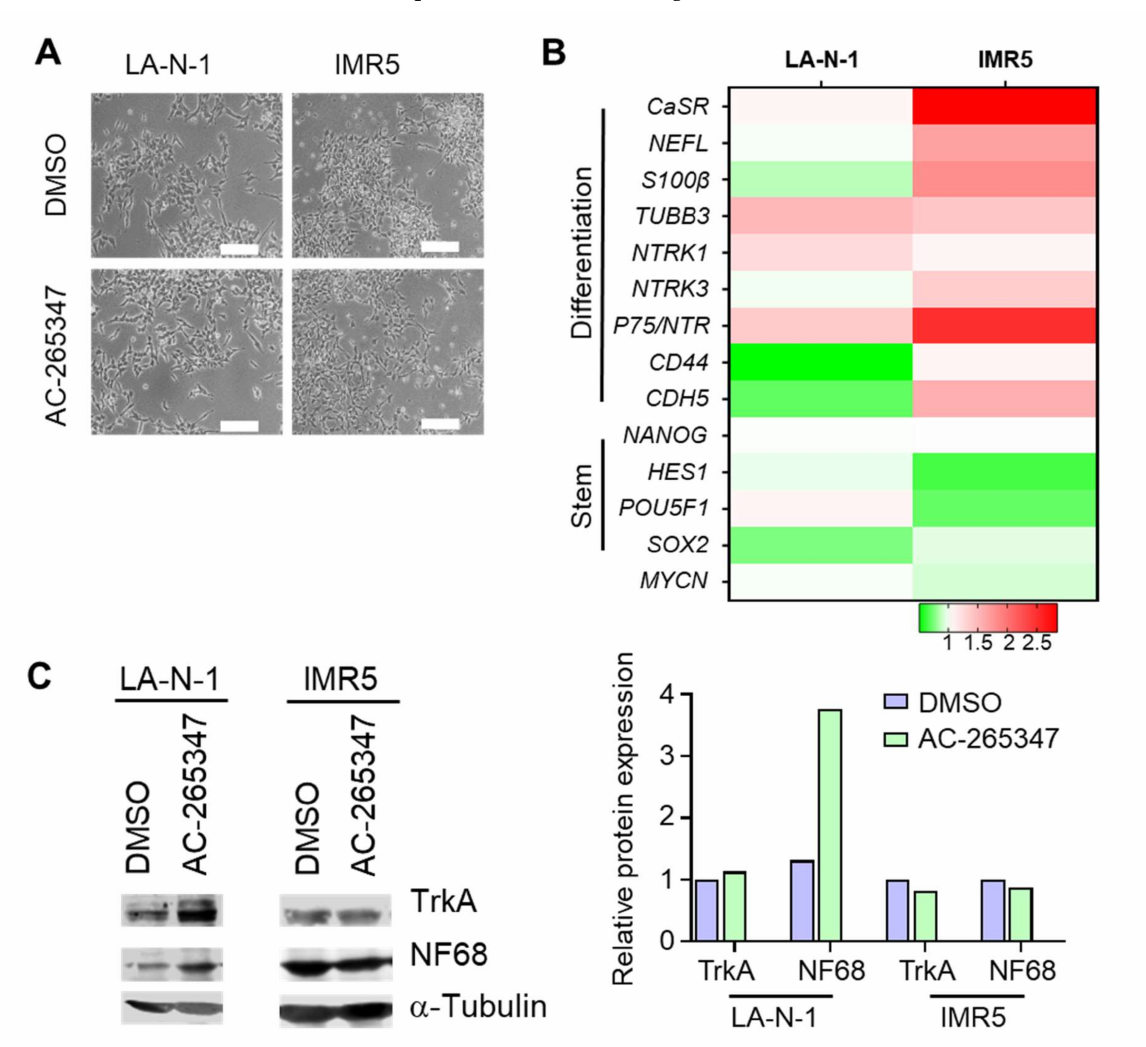
Figure 3. NB cell lines respond differently to chronic exposure to AC-265347. ( A ) Microphotography of LA-N-1 and IMR5 cells treated for 14 days with 1 µ M of AC-265347 or their vehicle (DMSO). Scale bar represents 500 px. ( B ) Heat-map comparing gene expression patterns in NB cells treated for 14 days with 1 µ M of AC-265347. Three independent experiments were performed. Statistical significance was calculated using one-way ANOVA with Dunn’s correction test. ( C ) Left: Immunoblot of TrkA, NF68 and α -Tubulin of LA-N-1 and IMR5 cells exposed to AC265347 for 14 days. Right: Quantification of immunoblots was done using ImageJ and bars represent band intensity relative to α